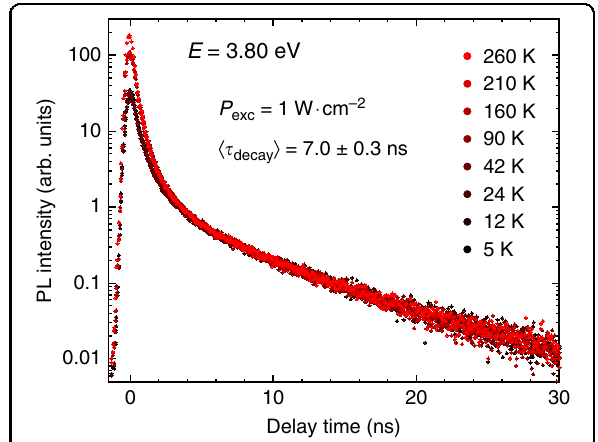
0 Fig. 9 Photoluminescence decays of GaN QDs emitting at 3.80 eV recorded from 5 to 260 K at an excitation power density of 1 W cm − 2 . All curves are stacked in order to superimpose the tail of the TRPL transients. The channel resolution was reduced down to 80 ps/ channel to improve the qualitative appraisal of decay time